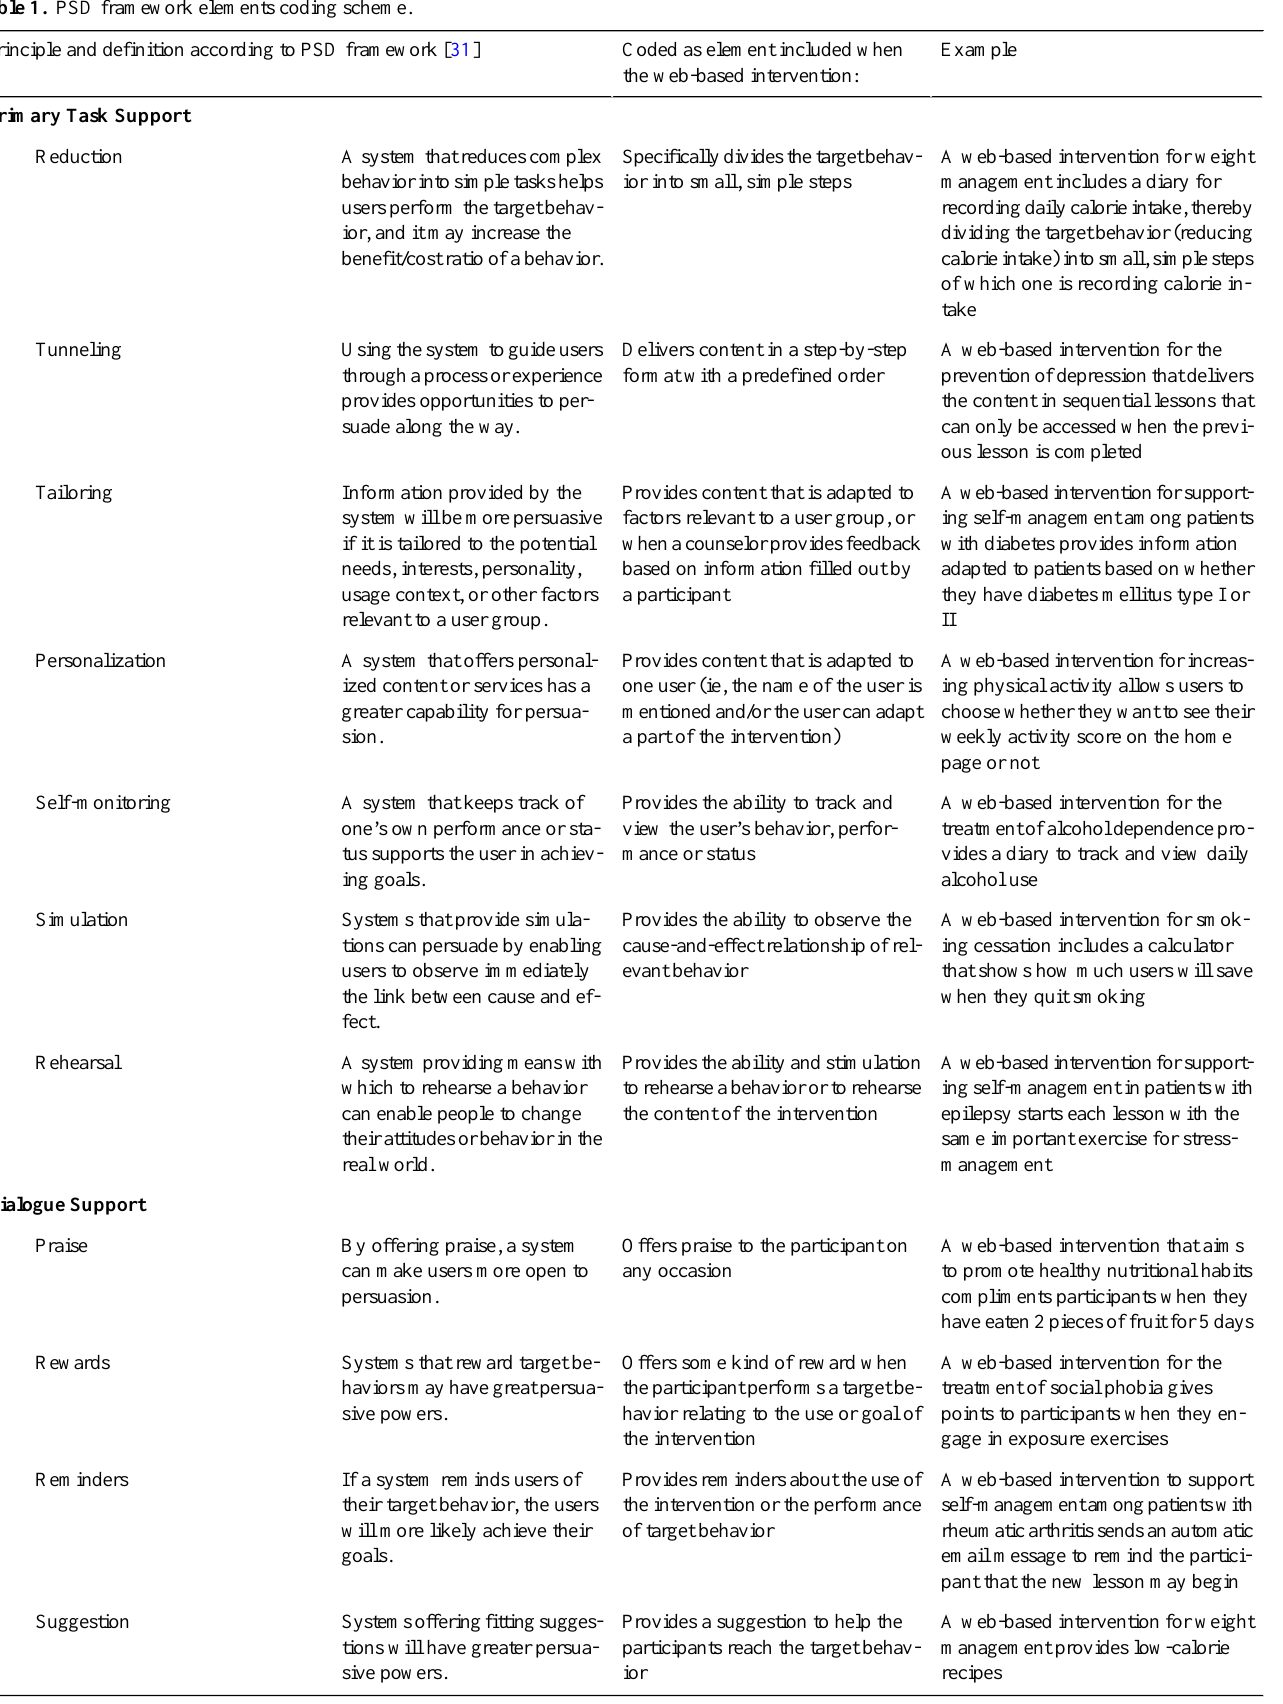
Table 1. PSD framework elements coding